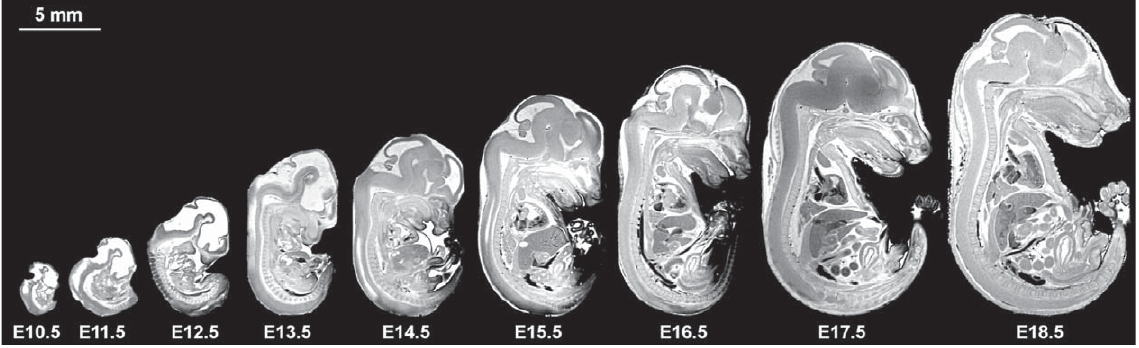
Fig. 14. Mid sagittal slices from volume datasets of developing mouse at stages E10.5– E18.5 illustrate differences in specimen scale occurring in less than 10 days during early development [91].